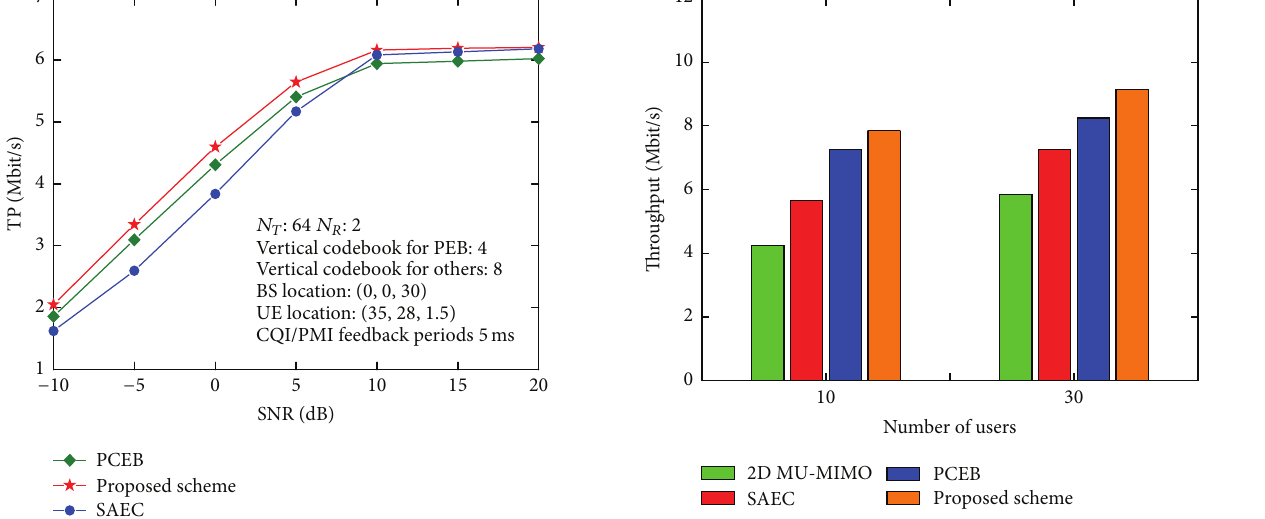
Figure 10: The throughput of different schemes in SU-MIMO sys- tem.